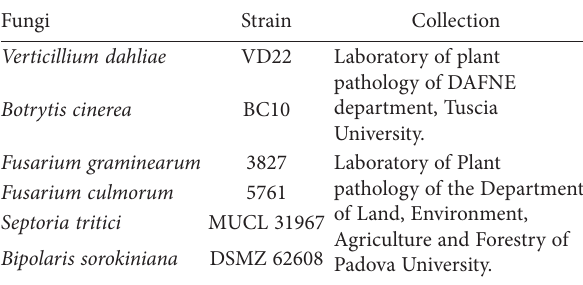
Table 1. Fungi and strains used for the preliminary